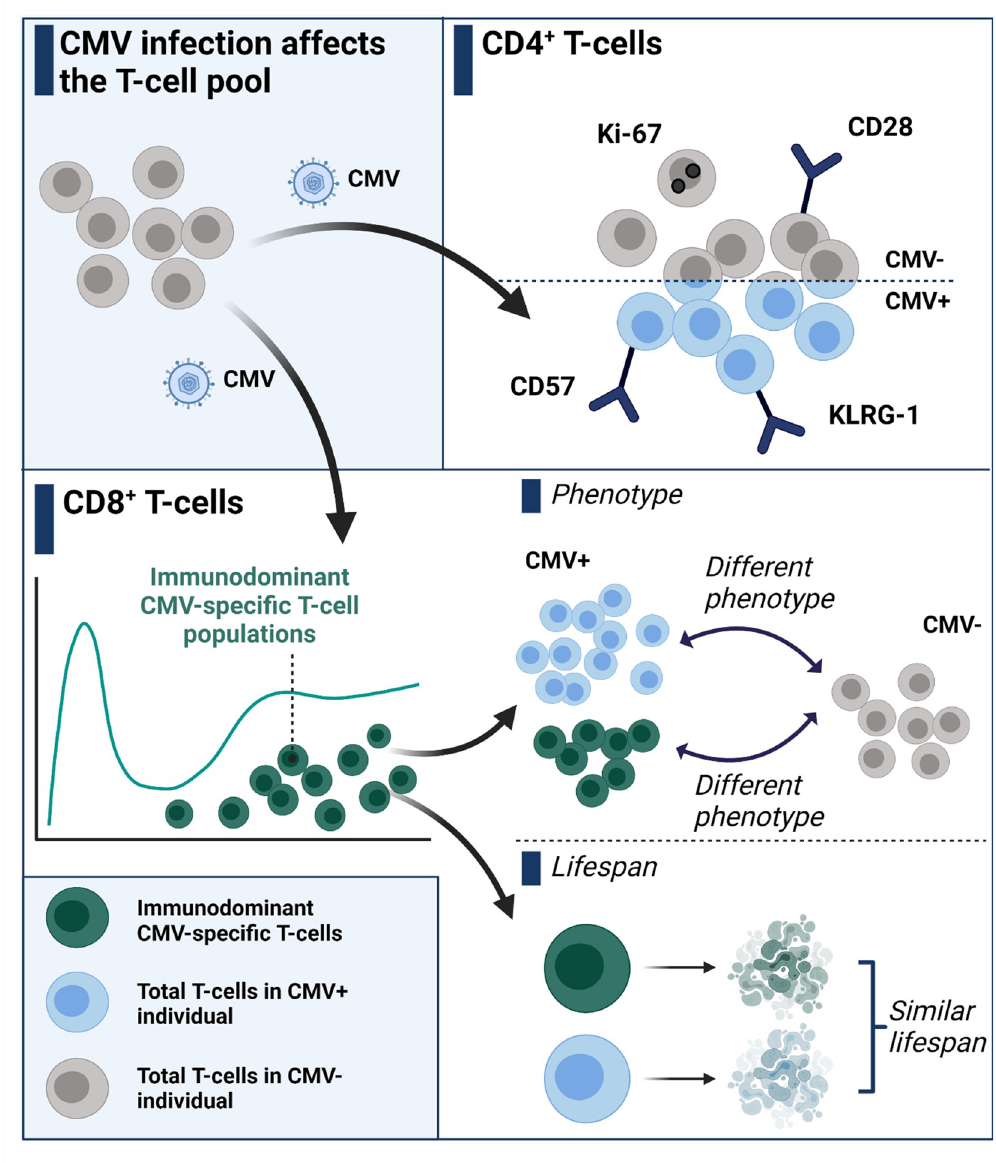
Fig 6. CMV infection affects the phenotype but not the lifespan of T-cells in humans. Both CD4 + and CD8 + T-cells in CMV-infected individuals upregulate the expression of senescence markers (e.g. CD57, KLRG-1) and downregulate the expression of co-stimulatory and proliferation markers (e.g. CD28, Ki-67). By separately analyzing the numerically large immunodominant CD8 + T-cell populations, we found that these do not explain the differences in T-cell phenotype between CMV+ and CMV- individuals. Though the increased late-differentiated state and size of the immunodominant CMV- specific CD8 + T-cell pool might suggest an altered lifespan, we find that these cells have similar lifespans as non-CMV- specific CD8 + T-cells. Created with